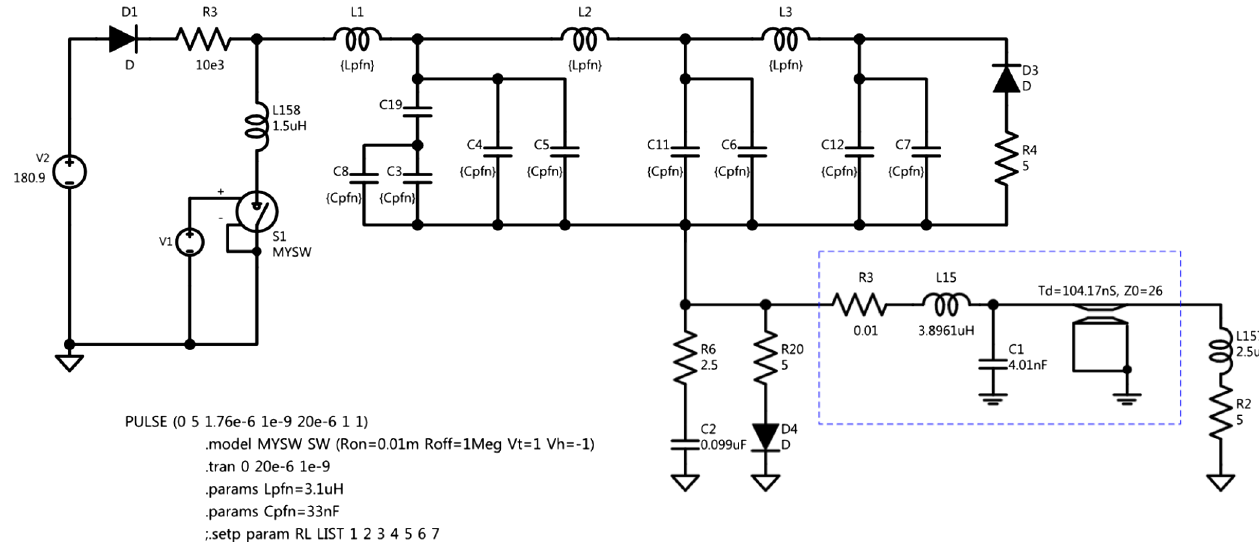
FIG. 5. Circuit diagram for the electric circuit simulation.